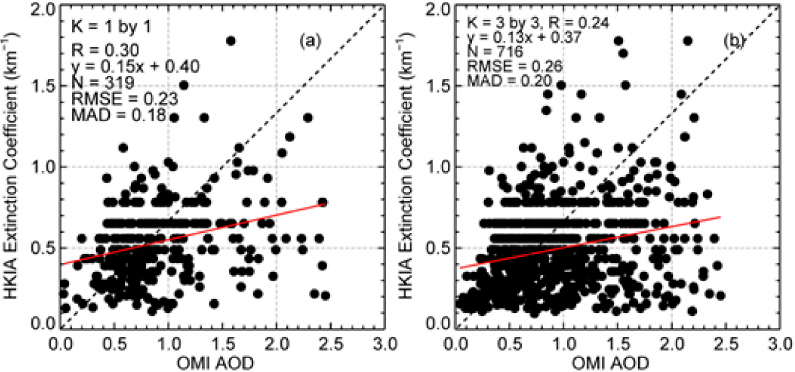
Figure 2. Correlation of B ext at HKIA with OMI AOD (27.8 km product at 483 nm) for kernel window of ( a ) 1 by 1 and ( b ) 3 by 3. Dashed line represents a 1:1 line, whereas solid line is the resultant regression line.